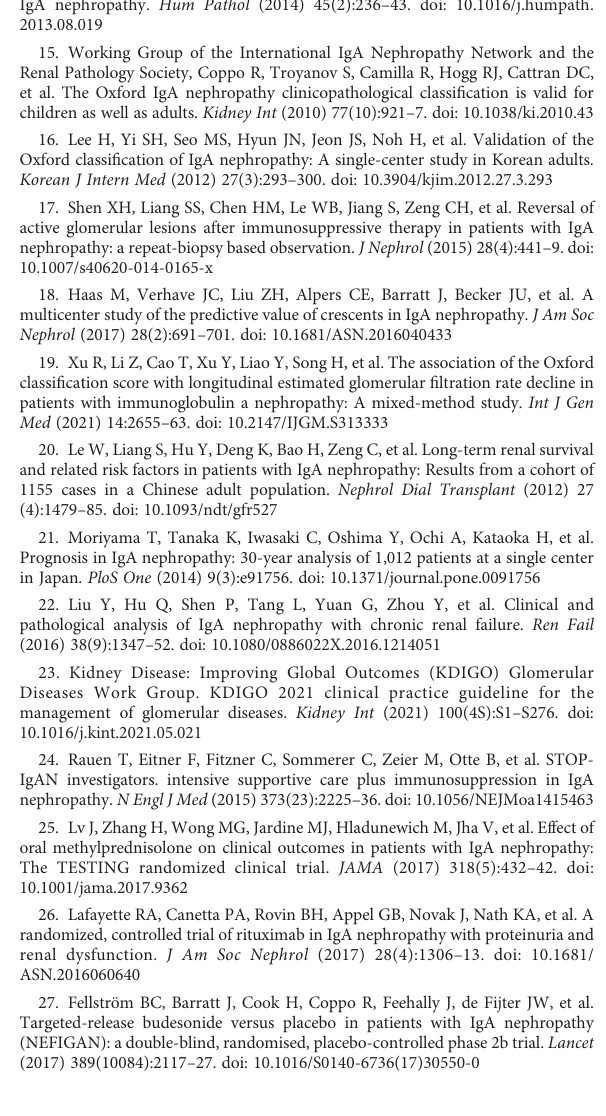
SUPPLEMENTARY FIGURE 1 The relationship between estimated glomerular fi ltration rate and proteinuria/creatinine ratio in patients with immunoglobulin A nephropathy. A non-linear relationship between estimated glomerular fi ltration rate and proteinuria/creatinine ratio was detected after adjusting for age, gender, mean arterial pressure, body mass index and the Oxford Classi fi cation MEST-C